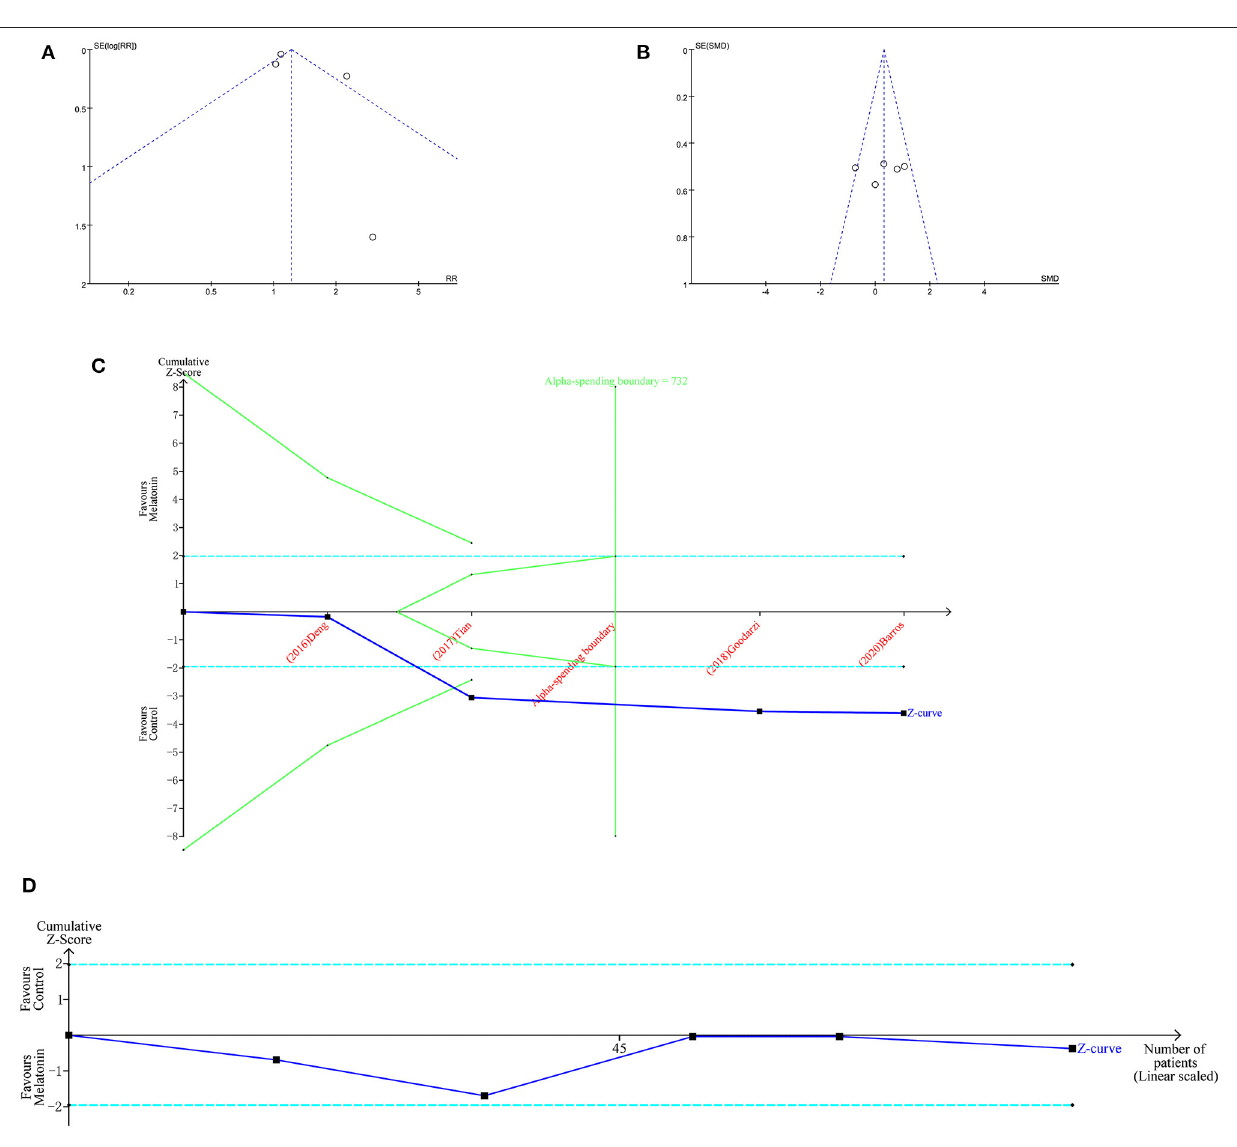
FIGURE 3 | Bias analysis and TSA of MT of sheep oocytes. Funnel plots of IVM rate (A) and implant ovulation rate (B) . TSA of IVM rate (C) and implant ovulation rate (D) .